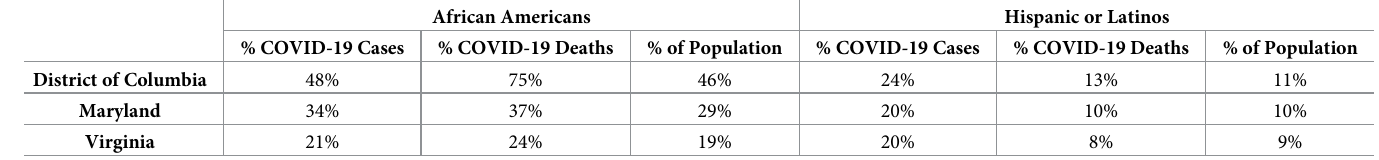
Table 3. Percentage of COVID-19 cases/deaths and population for African Americans and Hispanic/Latinos by DMV state. African Americans Hispanic or